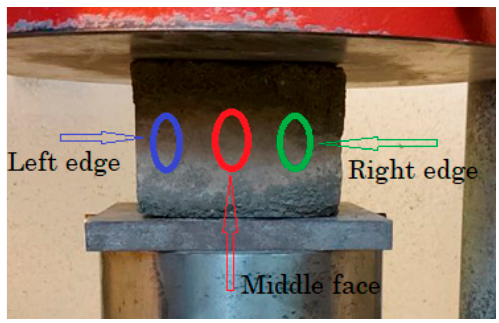
Figure 5. Location of rebound hammer